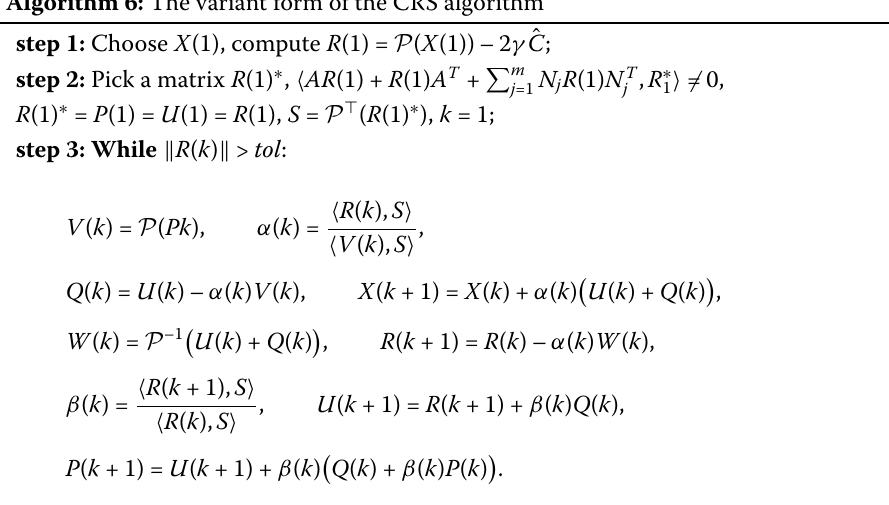
Algorithm 6: The variant form of the CRS